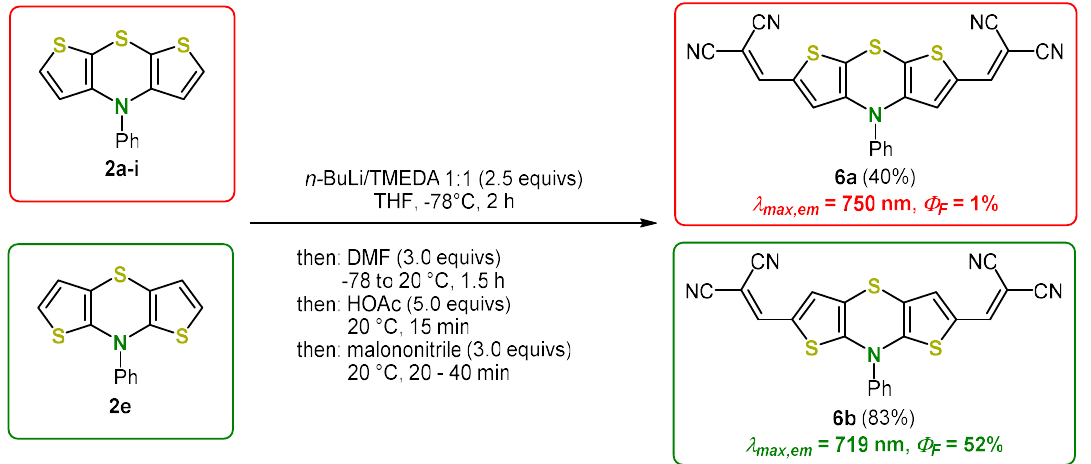
Scheme 12. Pseudo five-component one-pot synthesis of 2,6-diacceptor substituted syn - syn and anti